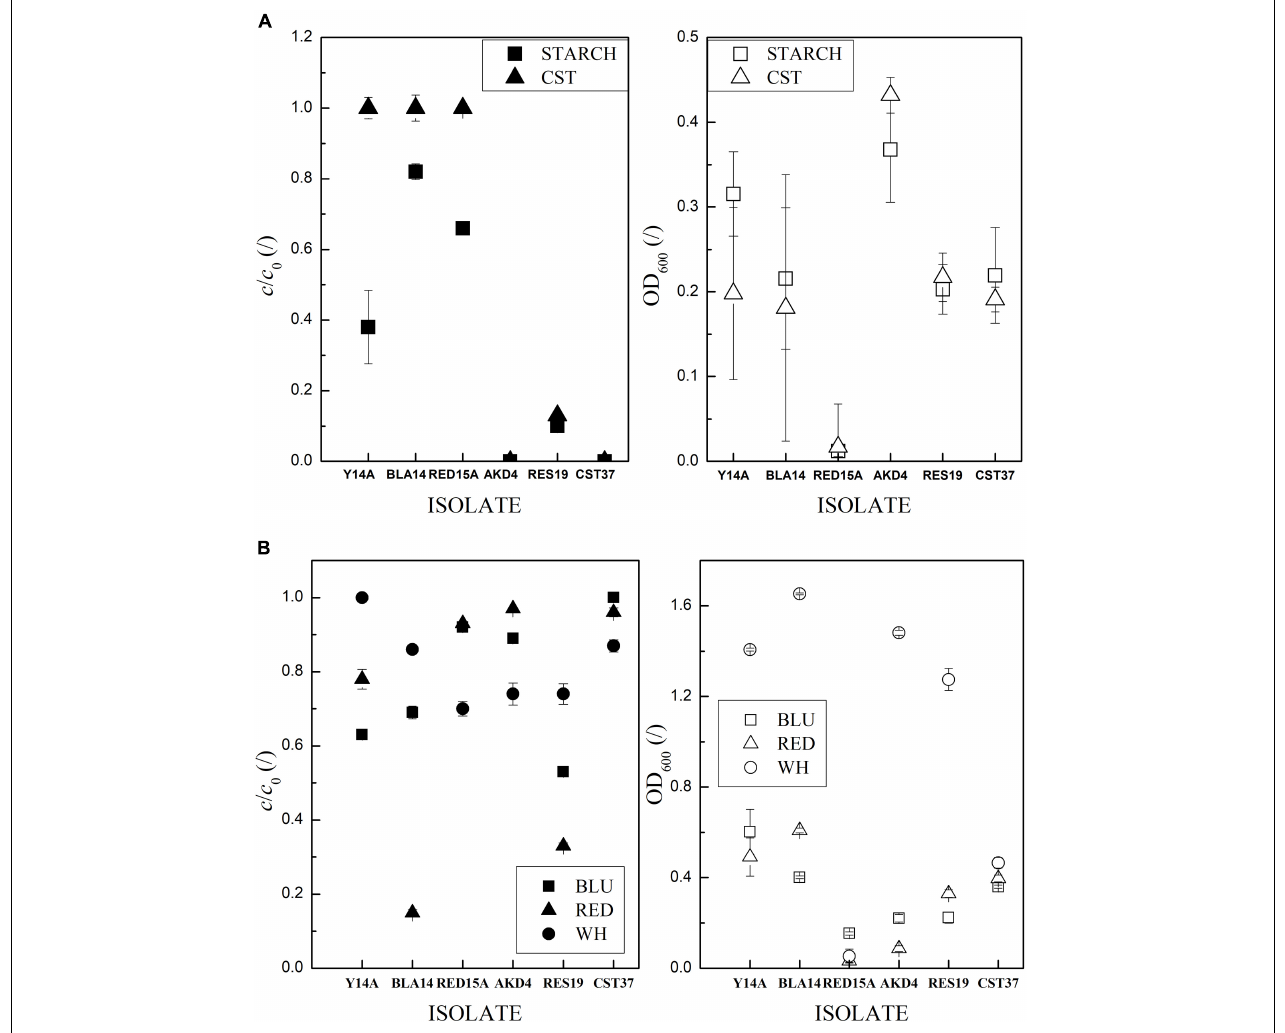
FIGURE 5 | Reservoir of carbon sources of the six selected isolates. Error bars indicate the RSE of triplicates. Low values of c / c 0 indicate high degradation activity. OD 600 are empty and c / c 0 full symbols. (A) Starch and (B) dyes and whitener in M9 Glc .